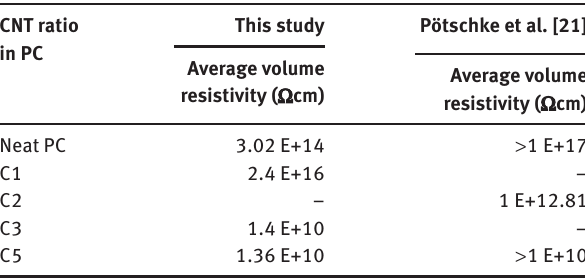
Table 9 Comparison of electrical test results with Pötschke’s